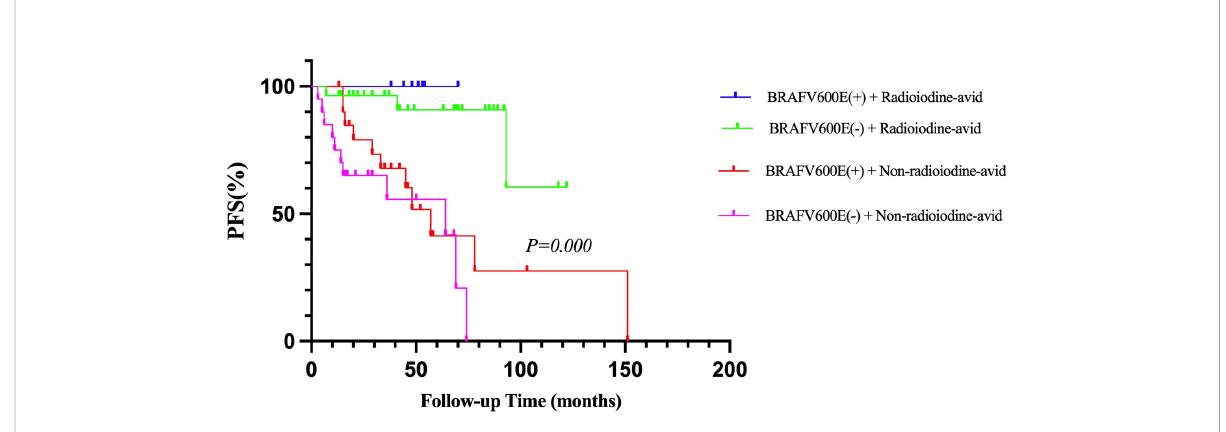
FIGURE 3 Kaplan – Meier analysis of PFS in PTC patients according to BRAF V600E mutation status combined with radioiodine avidity status. PFS, progression-free survival; PTC, papillary thyroid cancer.